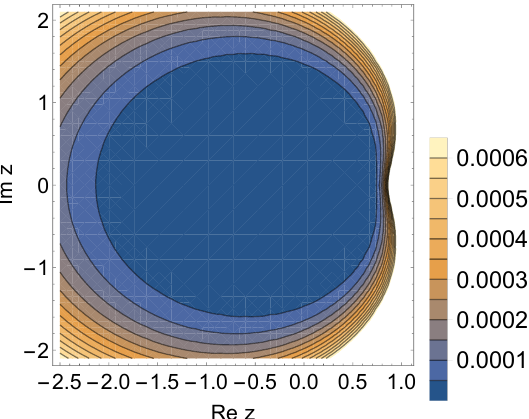
( z ) of (50) guarantees certain truncation error bounds 8